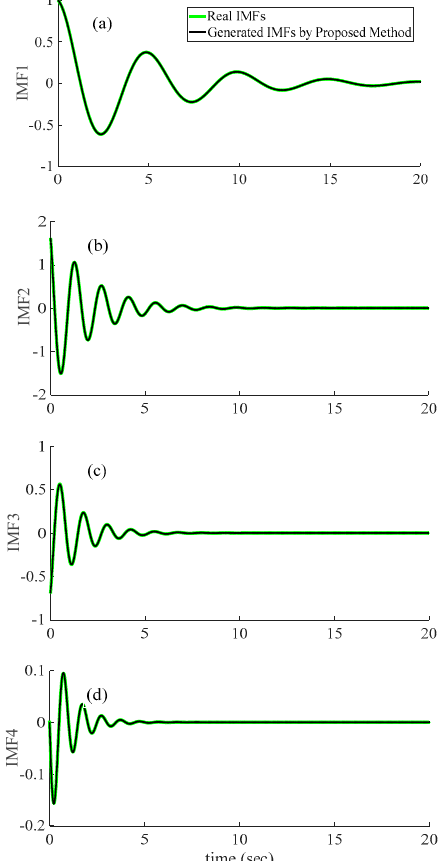
Figure 6. Comparison of real and estimated intrinsic mode functions (IMFs) of signal of Test Case 1.